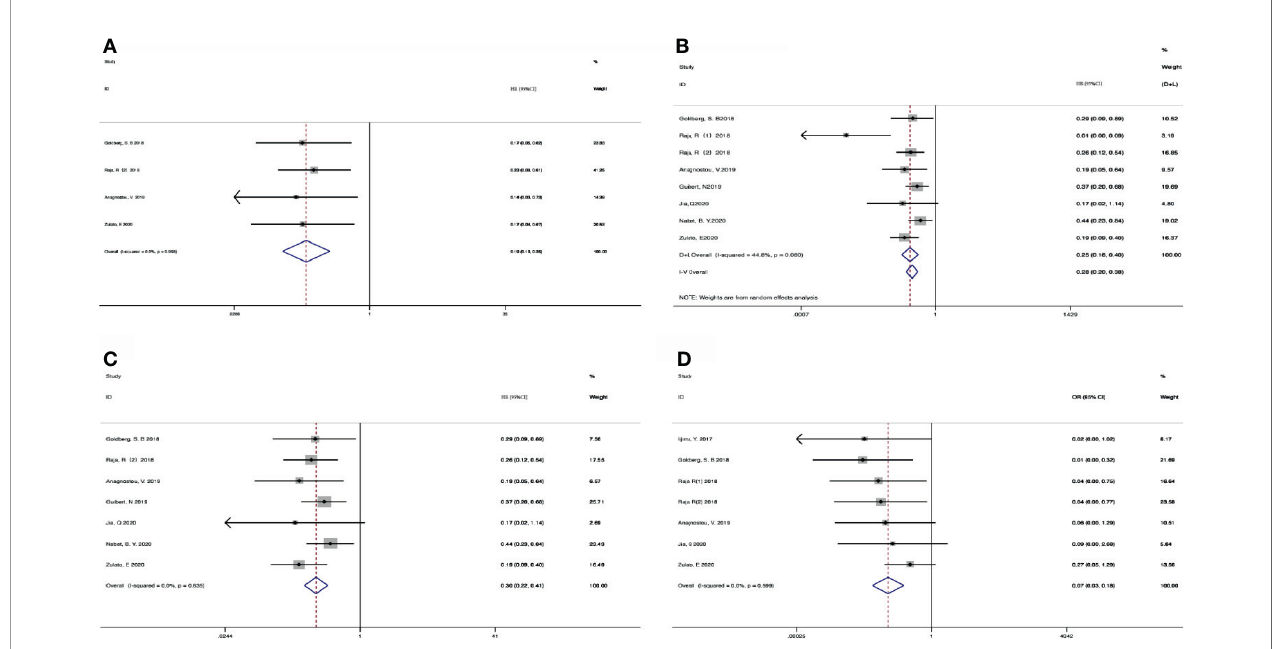
FIGURE 3 | Meta-analysis of the associations between early reduction of ctDNA and (A) overall survival, (B, C) progression-free survival, (D) objective response